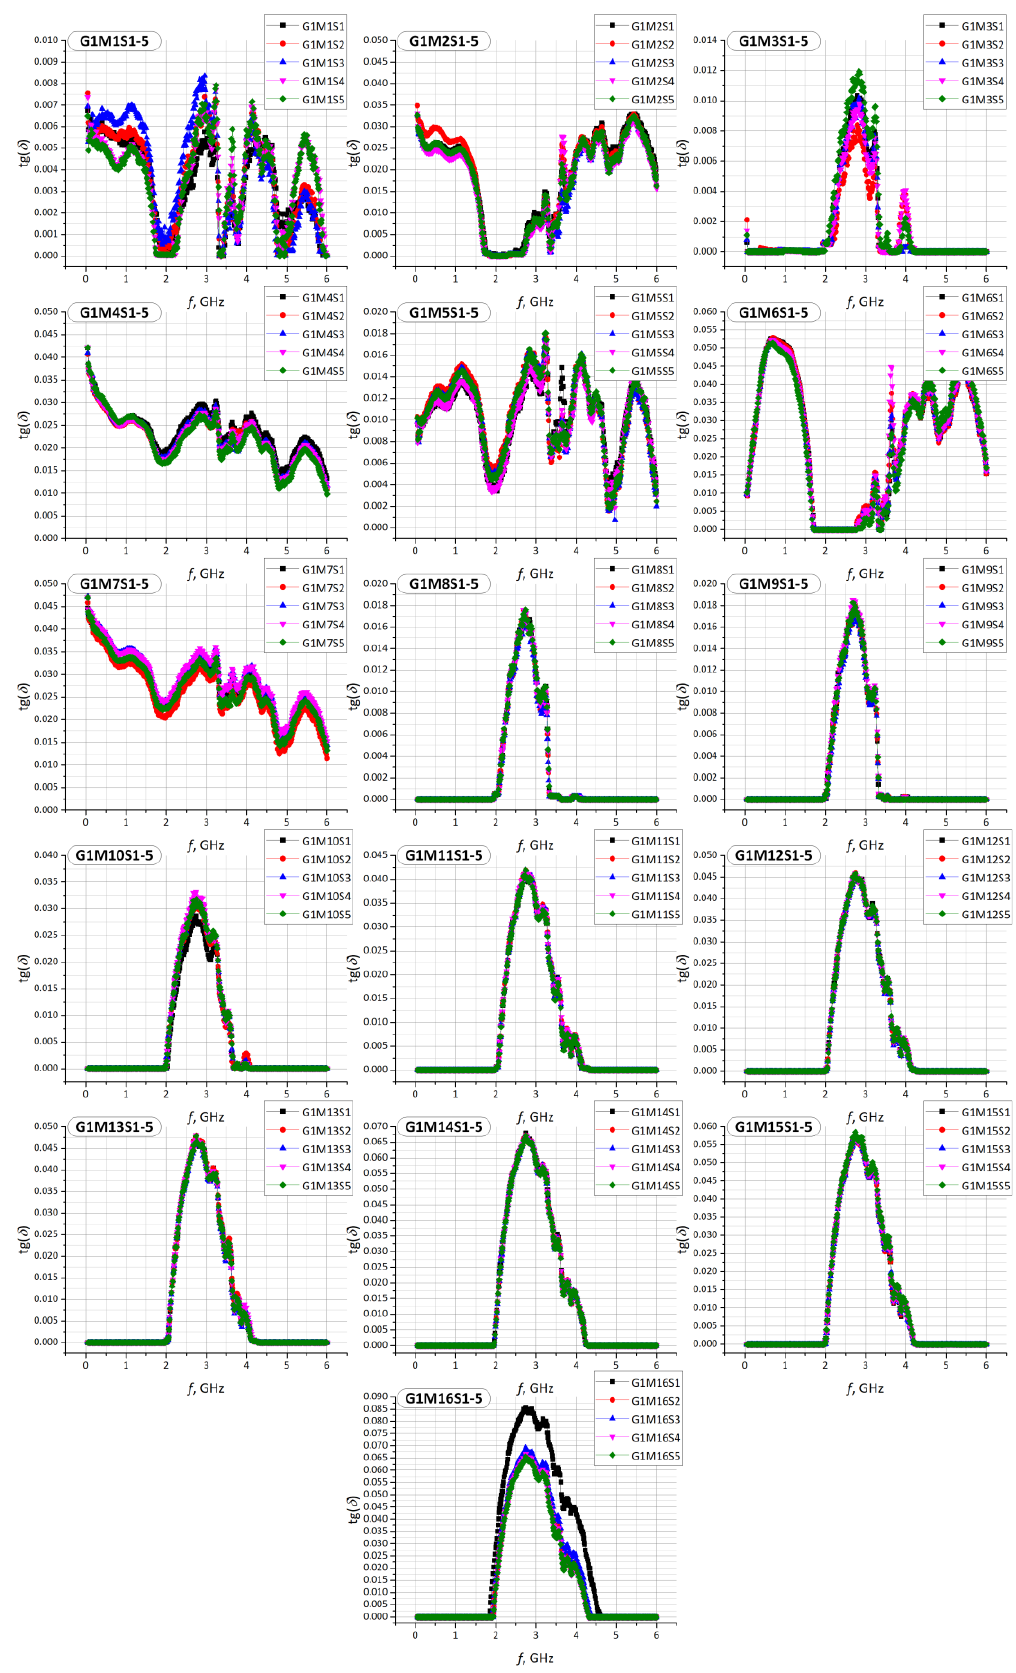
Figure 12. Results of tg δ measurements for every sample of S1 – S5 in G1 (G1M1S z – G1M16S z ) group.